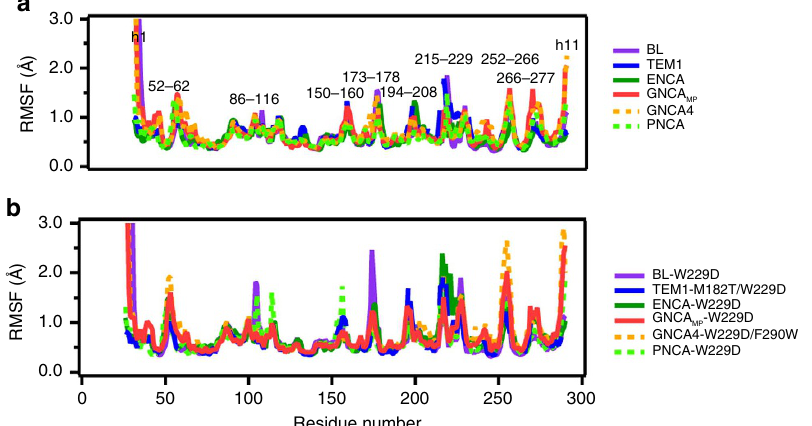
Figure 8 | C a -atom root mean square fluctuations of all simulated variants. Shown here are the root mean square fluctuations (RMSF, Å) of all C a atoms during our simulations of ( a ) wild-type and ( b ) variant forms of the TEM-1 (blue), Bacillus licheniformis (purple), GNCA MP (red), GNCA4 (orange), ENCA (dark green) and PNCA (light green) b -lactamases. In the case of the variant forms, the simulations were performed both in the absence of the transition- state analogue (TSA) or in complex with the TSA, 5(6)-nitrobenzotriazole. The simulations shown in ( b ) were all performed in the absence of the TSA, and a corresponding comparison of the C a RMSF values of the ancestral enzymes both with and without the TSA present are shown in Supplementary Fig. 29. All values shown here are averages over the last 60ns of three independent trajectories (180ns total simulation time), which were obtained as described in the Methods